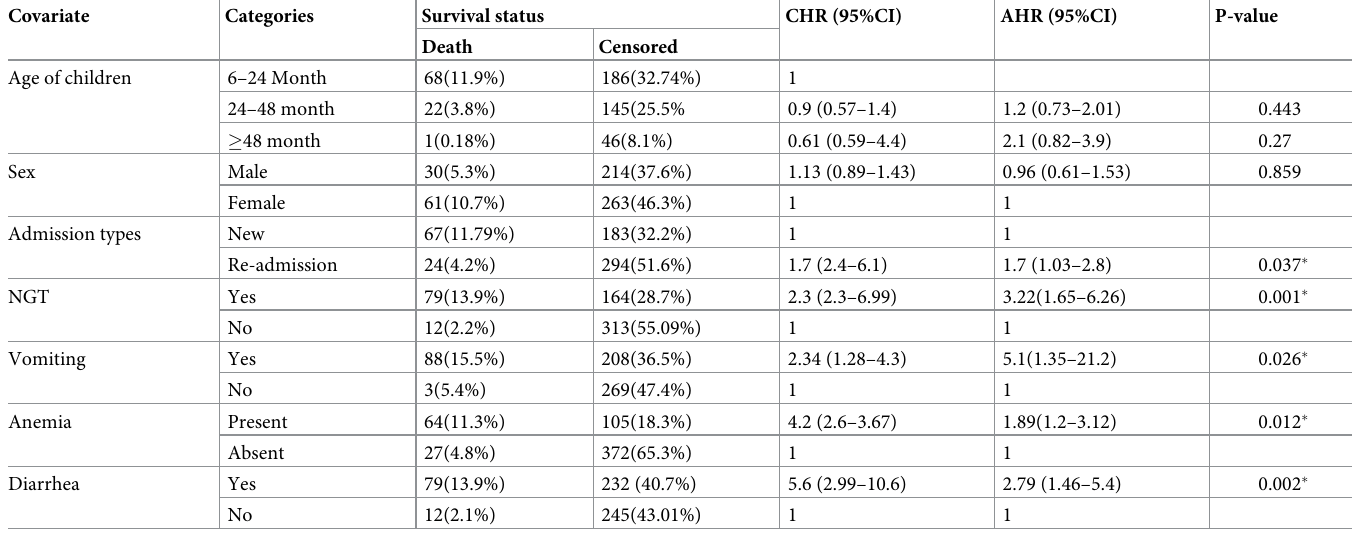
Table 4. Bi-variable and multivariable Cox regression for predictors of mortality.